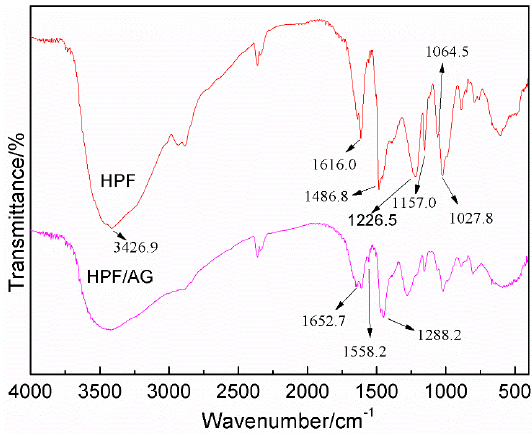
Figure 5. FT-IR spectra of samples HPF and HPF/AG.